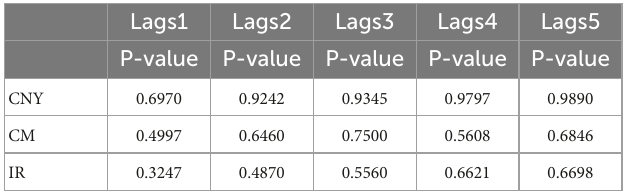
TABLE 3 ARCH test after modeling